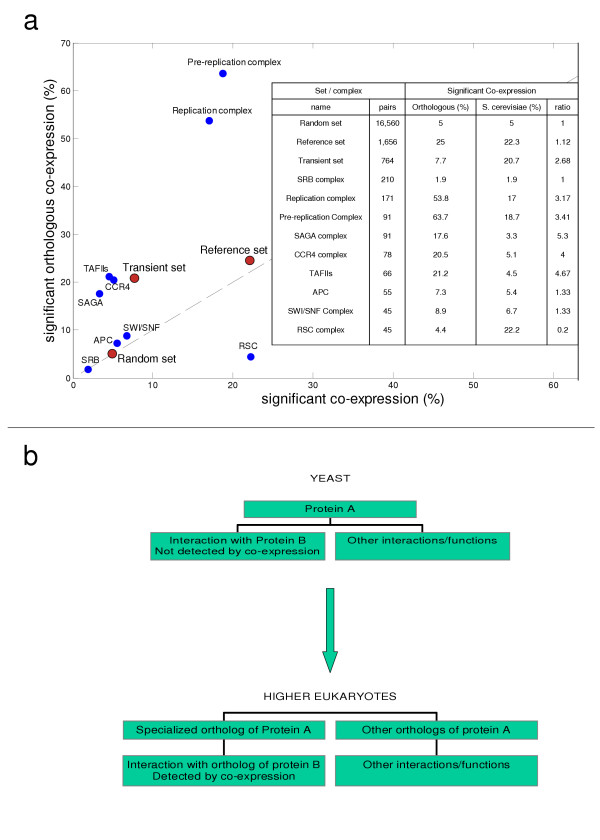
Detection of transient interactions. (a) Each circle shows the percentage of protein-pairs in a specific set/complex with a significant level (P-value < 0.05) of S. cerevisiae and orthologous co-expression in the horizontal and vertical axes, respectively. Blue circles represent all pair-wise interactions in a single transient complex; Red circles represent the three sets of protein-pairs (random, reference and transient). The dashed line indicates similar performance of both methods. The table also shows the number of protein-pairs in each set/complex, and the ratio between the percentage of pairs with significant orthologous and S. cerevisiae co-expression, respectively. (b) Proposed model for transient yeast interactions with low co-expression, but high orthologous co-expression. Protein A interacts with protein B, but also performs other functions or interacts with other proteins, such that it is not co-expressed with protein B. However, in higher eukaryotes, a specialized ortholog of A exist, which is co-expressed with the ortholog of B.